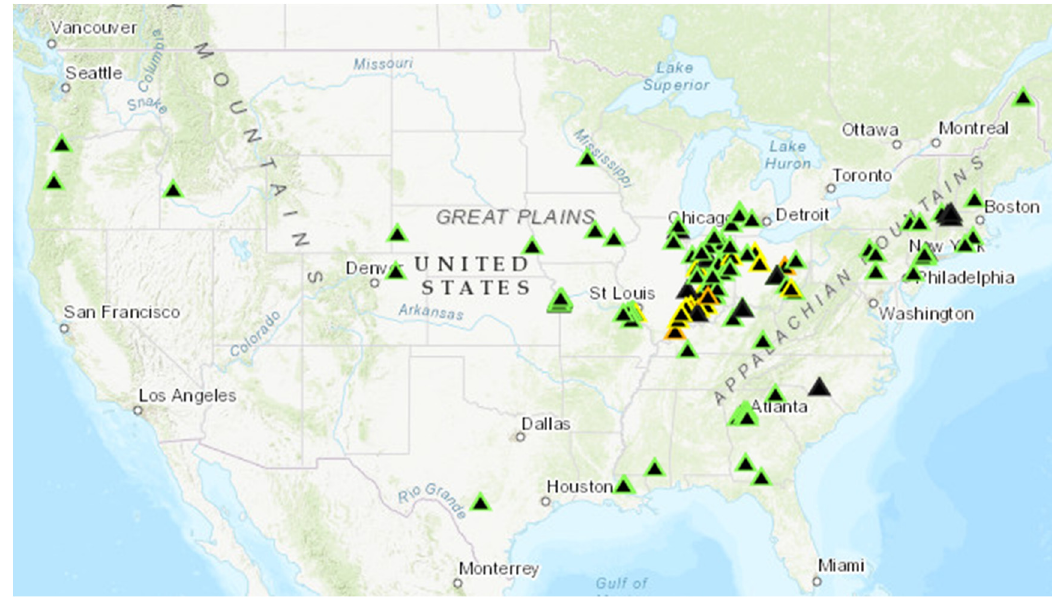
Figure 12. Available flood mapping locations in Flood Inundation Mapper (FIM) [42].